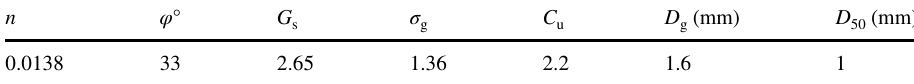
Table 1 Properties of the bed